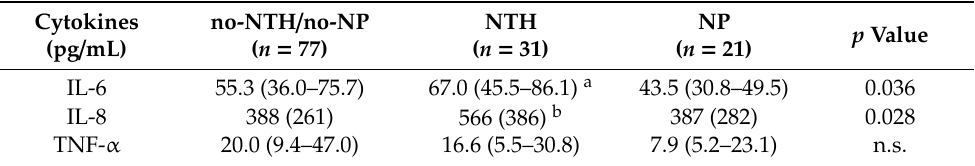
Table 4. Salivary IL-6, IL-8, and TNF- α levels in CF patients with and without inferior turbinate hypertrophy (NTH) and nasal polyposis (NP).